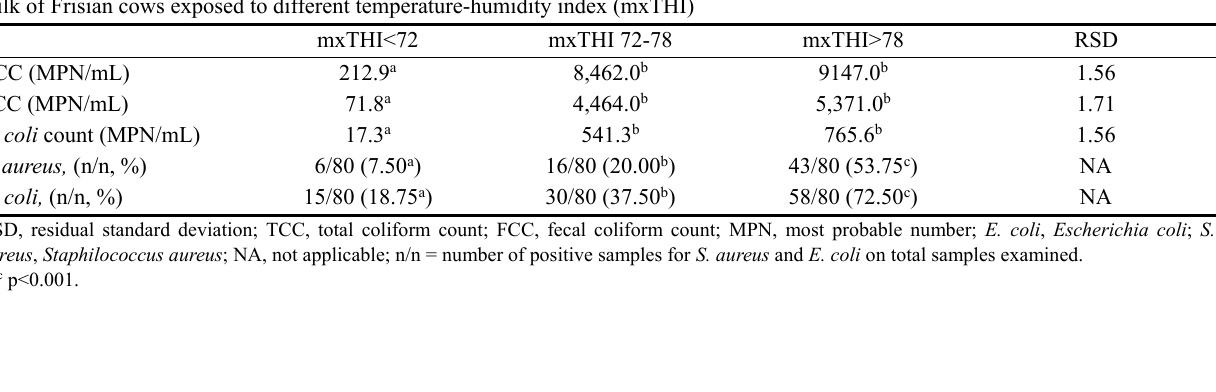
Table 4. Least square means of milk total coliform count, fecal coliform count, E. coli count, and S. aureus and E. coli isolation from milk of Frisian cows exposed to different temperature-humidity index (mxTHI)